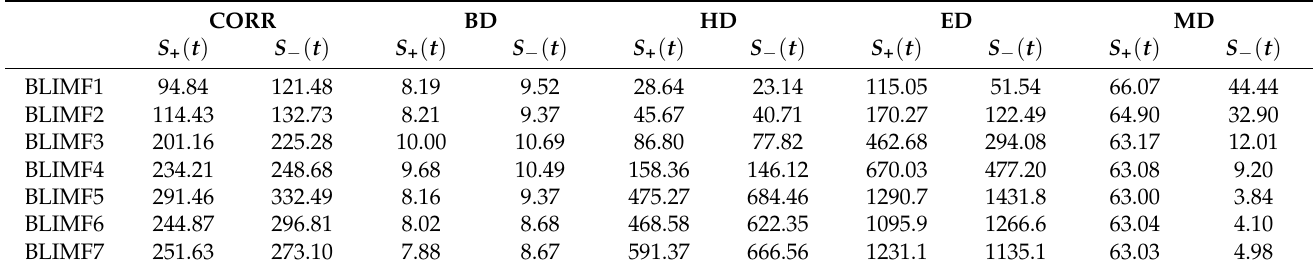
Figure 8. Mahalanobis distance between S ( t ) and the BLIMFs. Table 2. Comparisons of different